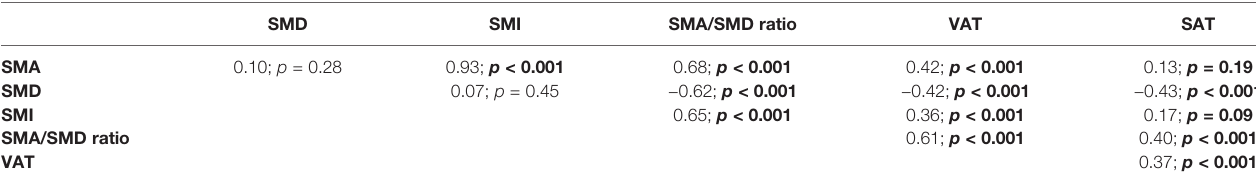
TABLE 6 | Pearson ’ s correlations between skeletal muscle parameters and adipose tissue parameters.